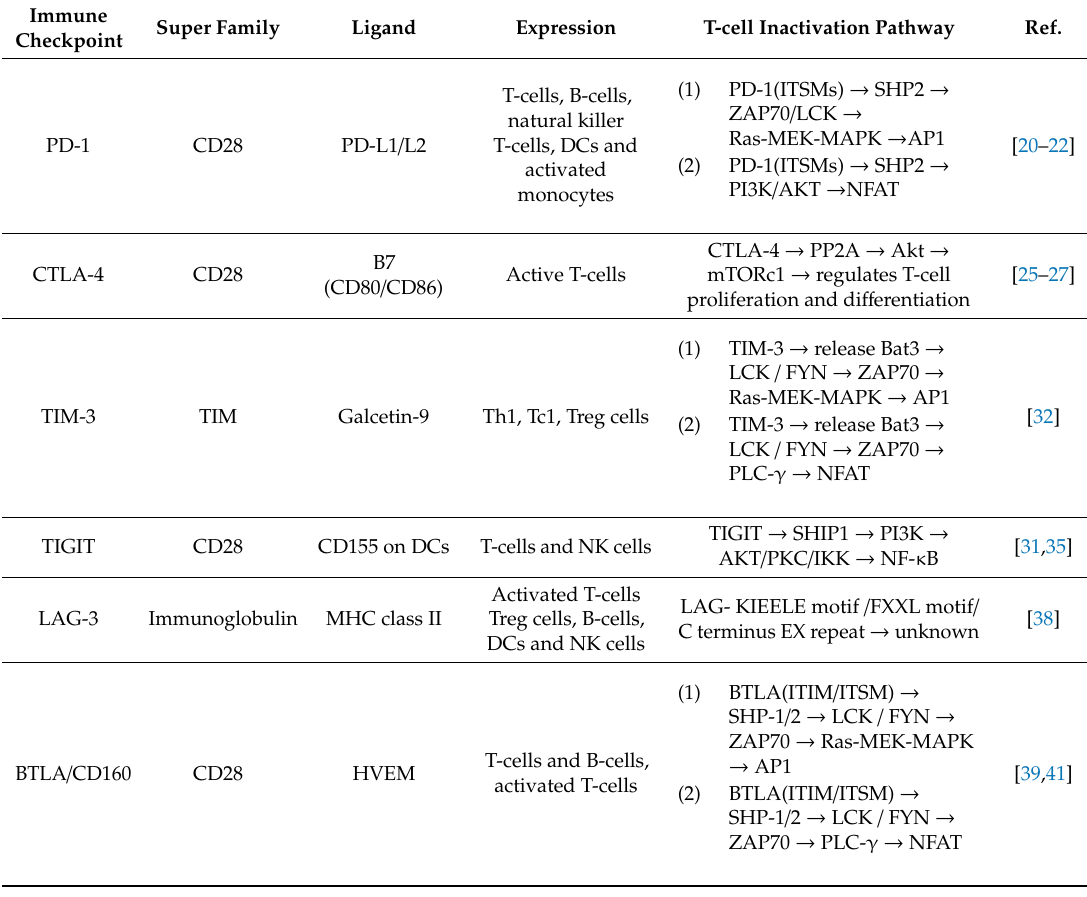
Table 1. Immune checkpoints involved in viral infections and their T-cell inactivation